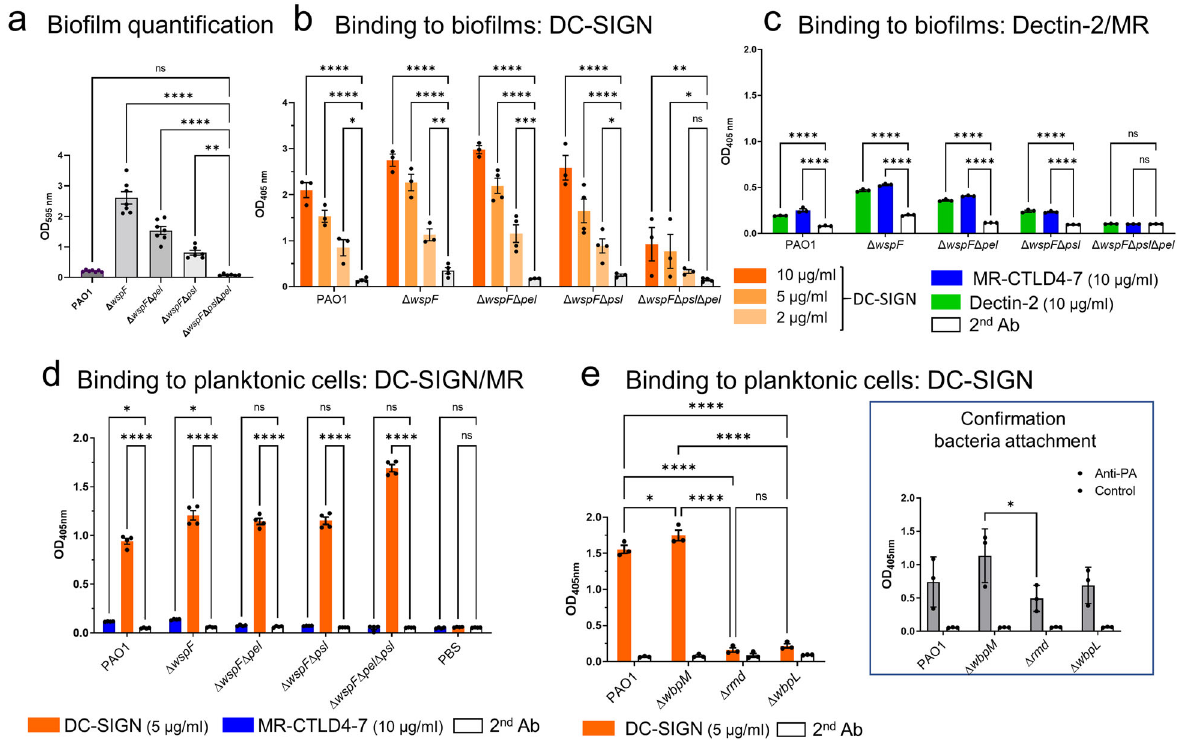
Fig. 1 Binding of C-type DC-SIGN, MR and Dectin-2 to P. aeruginosa bio fi lms and planktonic cells. a PAO1, Δ wspF (Psl + /Pel + ), Δ wspF Δ pel (Psl + /Pel-), Δ wspF Δ psl (Psl-/Pel + ) and Δ wspF Δ psl Δ pel (Psl-/Pel-) were grown in 96-well plates for 24 h in X-Vivo-15 and bio fi lm formation was analysed using the crystal violet assay. Data analysed using One-way ANOVA and corrected for multiple comparisons using Dunnett ’ s multiple comparison test. N = 6-7 in triplicate. ** 0.001; **** <0.0001. b and c . PAO1, Δ wspF , Δ wspF Δ pel or Δ wspF Δ psl bio fi lms were generated in 96-well plates for 24 h, fi xed and incubated with DC-SIGN-Fc (B) or MR-CTLD4-7-Fc or Dectin-2-Fc (C) followed by anti-human Fc secondary antibody conjugated to alkaline phosphatase. Cultures of Δ wspF Δ psl Δ pel were used as controls. Analysis performed using Two-way ANOVA corrected for multiple comparisons using the Dunnett ’ s multiple comparisons test. N = 3 in triplicate. In B * 0.0324 (for Δ wspF Δ psl ); 0.0413 for Δ wspF Δ psl Δ pel; ** 0.007 ; *** 0.0007 ; **** <0.0001. In C **** <0.0001. d Planktonic cultures of P. aeruginosa PAO1 and the different mutants were collected, fi xed and used to coat wells of MaxiSorp plates. Wells were incubated with MR-CTLD4-7-Fc or DC-SIGN-Fc followed by anti- human Fc secondary antibody conjugated to alkaline phosphatase. DC-SIGN, but not MR, bound planktonic bacteria and binding was independent of the presence of Psl and/or Pel. Two-way ANOVA corrected for multiple comparisons using the Dunnett ’ s multiple comparisons test. N = 4 in triplicate. *, 0.0412 for PAO1 and 0.0148 for Δ wspF ; ****, <0.0001. e . DC-SIGN binding to planktonic bacteria was dependent on the presence of CPA LPS which is absent in the Δ rmd and Δ wbpL mutants. N = 3 in triplicate. *, 0.0111; ****, <0.0001. Right panel: Adherence of planktonic cells to the wells was con fi rmed by ELISA using an antibody against P. aeruginosa (Anti-PA). N = 3 in triplicate. *, 0.0161. Analysis performed using Two-way ANOVA corrected for multiple comparisons using the Tukey ’ s multiple comparisons test. Graphs show mean + / − SEM. Speci fi city controls for these assays are shown in Fig. S1. In all cases, reading were taken within 20 min development and all strains in each graph were tested